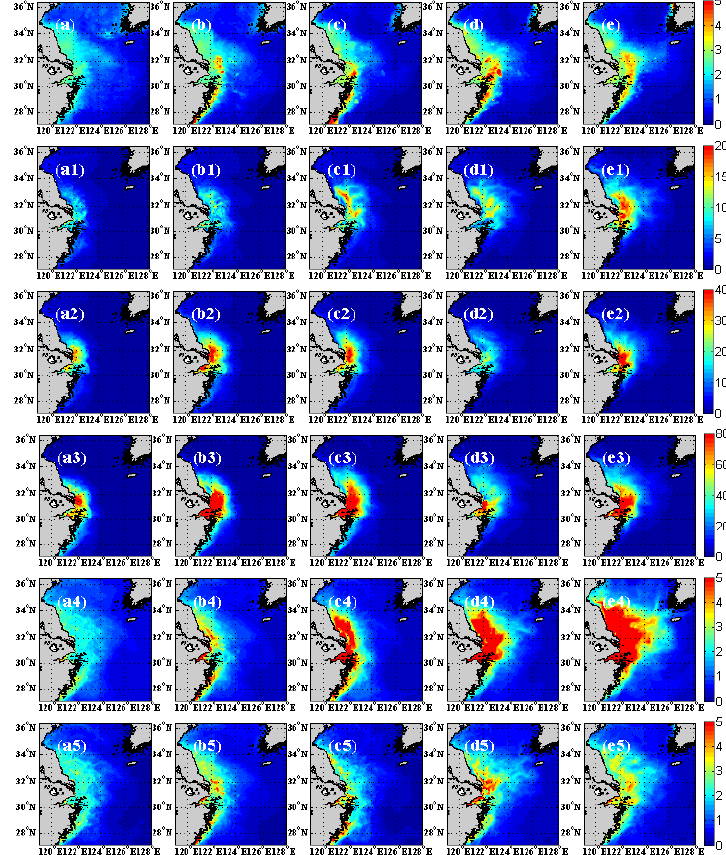
Figure 6. Monthly chlorophyll concentration of SeaWiFS from April to August (13-year average from 1998–2010) of Yangtze River estuary ( a – e , top row). The ( a1 – e5 ) are the same as ( a – e ), but for the model results (five cases). The figures in the second row ( a1 – e1 ) are for Case 1. The figures in the third row ( a2 – e2 ) are from Case 2. The figures in the fourth row ( a3 – e3 ) are from Case 3. The figures in the fifth row ( a4 – e4 ) are from Case 4. The figures in the sixth row ( a5 – e5 ) are from Case 5. We also compared the time series of seasonal variation of chlorophyll concentration from SeaWiFS with the model result (13-year average from 1998–2010). Figure 7 shows the time series of monthly chlorophyll concentration from SeaWiFS and simulation results by using the fifth specific growth rate of phytoplankton equation from April to August. We note that both SeaWiFS and Case 5 show two peaks from April to August, and their values are very close. The above analysis indicated that the model can reproduce the seasonal evolution of chlorophyll